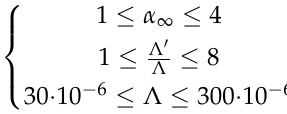
Table 1. Experimentally obtained values for the flow resistivity of the considered RPUFs.